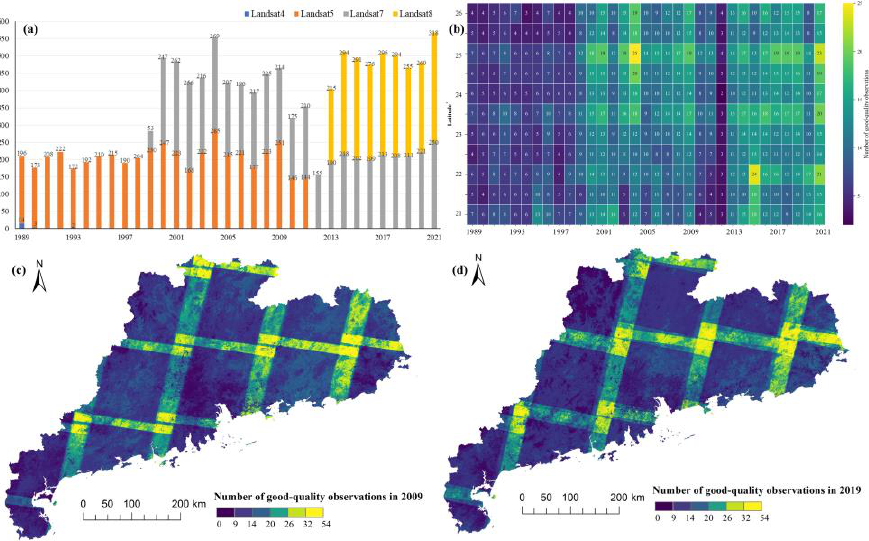
Figure 2. Statistics on yearly of availability Landsat imagery with number of scenes ( a ) and number of good-quality observations of Landsat by latitude ( b ) from 1989 to 2021. Number of good-quality observations of Landsat for Guangdong Province in 2009 ( c ) and 2019 ( d ).